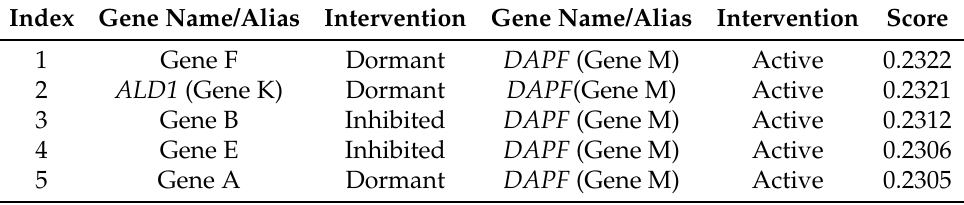
Table 2. Top five pairwise intervention strategies under saline stress